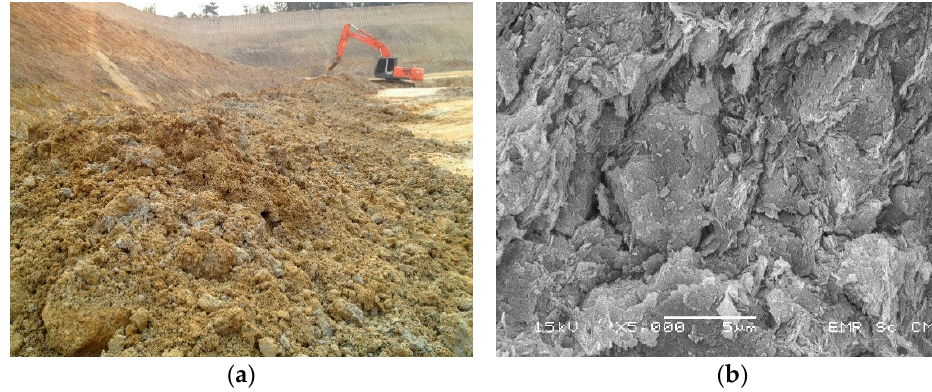
Figure 5. Lateritic soil ( a ) in overview; ( b ) microstructure.